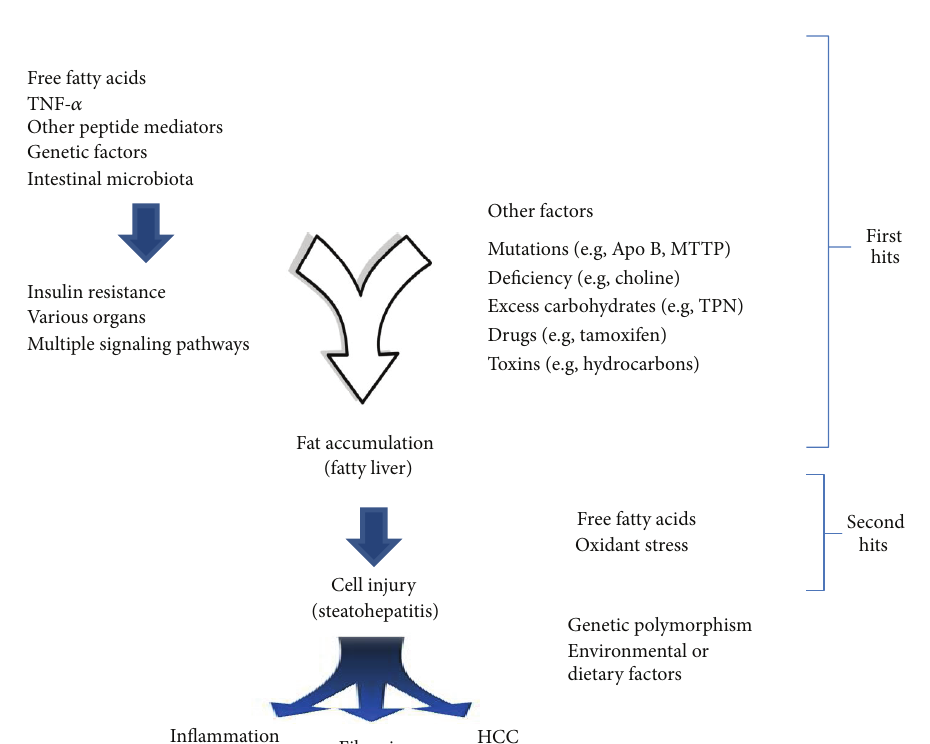
Figure 1: Postulated mechanisms of fat-induced inflammation and fibrosis in NAFLD and NASH. Modified from [79].